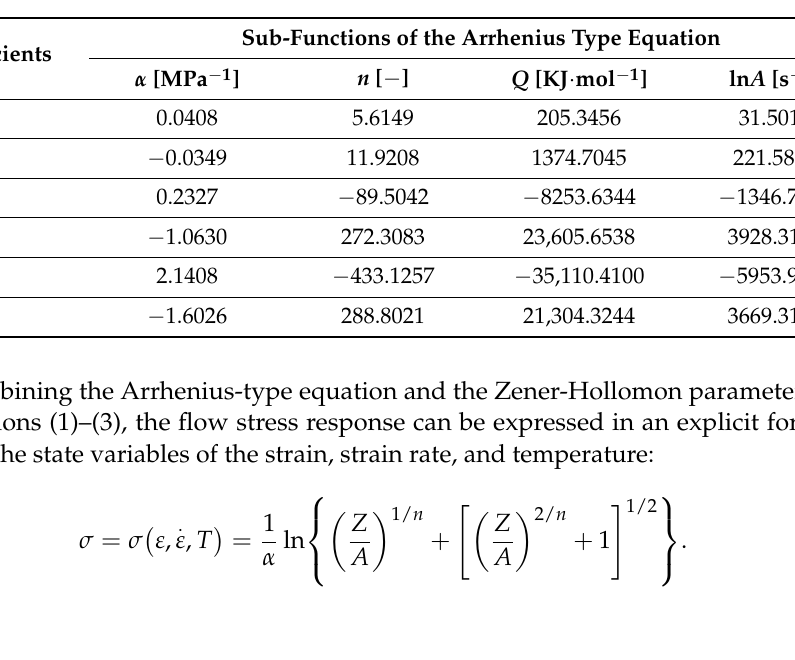
Table 2. Coefficients of the strain rate- and temperature-dependent strain hardening